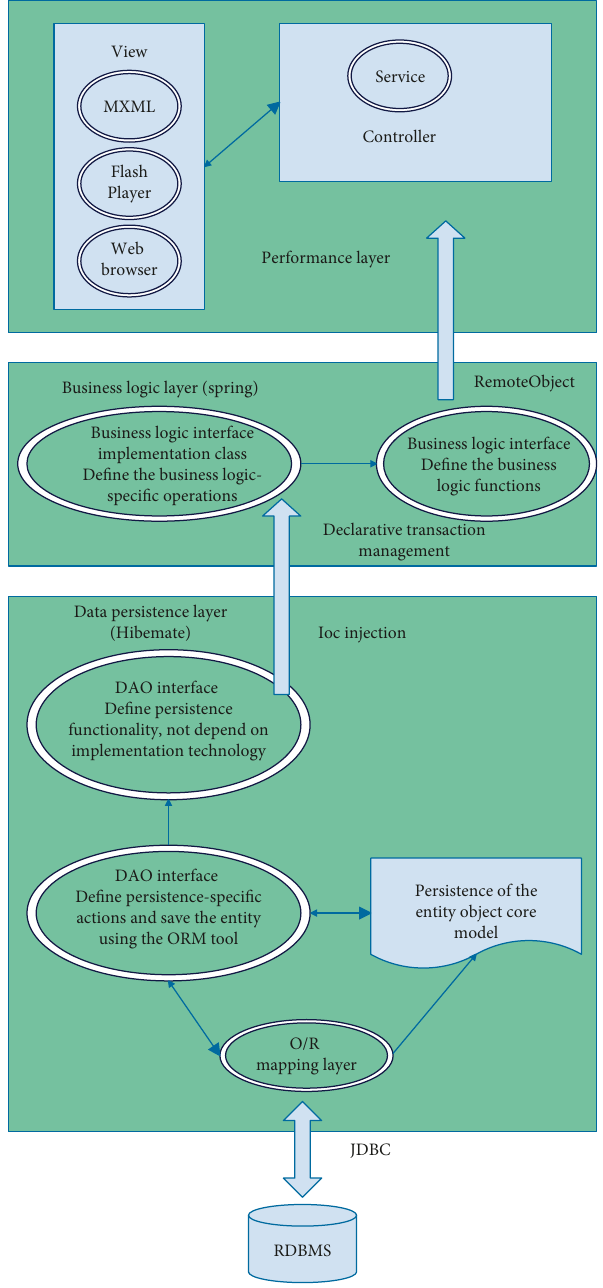
Figure 3: Overall architecture diagram of the platform.